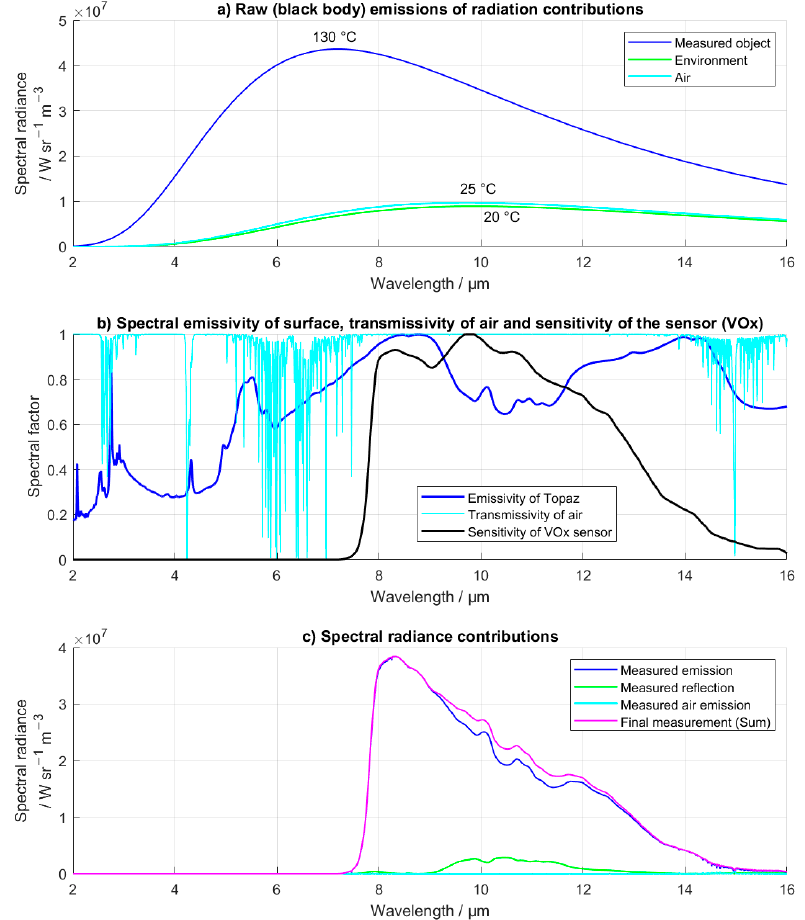
Figure 8. Shown is the spectrally simulated behaviour of the direct model with ( a ) the raw spectral radiance of black body emissions; ( b ) the spectral emissivity of surface, the spectral transmissivity of the air, and the spectral sensitivity of the sensor; and ( c ) the partial and total spectral radiance, as absorbed in the sensor. The area under the sum of all contributions represents the signal output from the sensor.